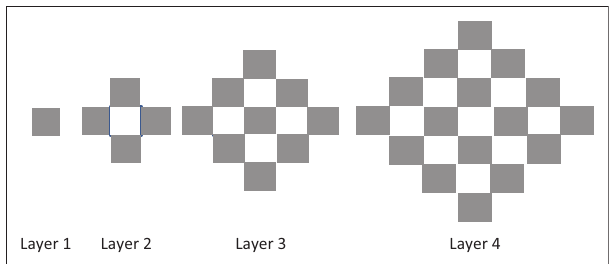
FIGURE 3: Pyramid layers with cubes coloured differently for